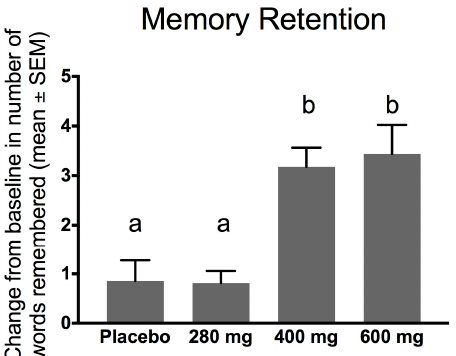
Figure 4. Memory retention measured as change in number of words remembered before and after 3 weeks of daily ingestion of fibroin protein enzymatic hydrolysate (FPEH) is exhibited on the y -axis.